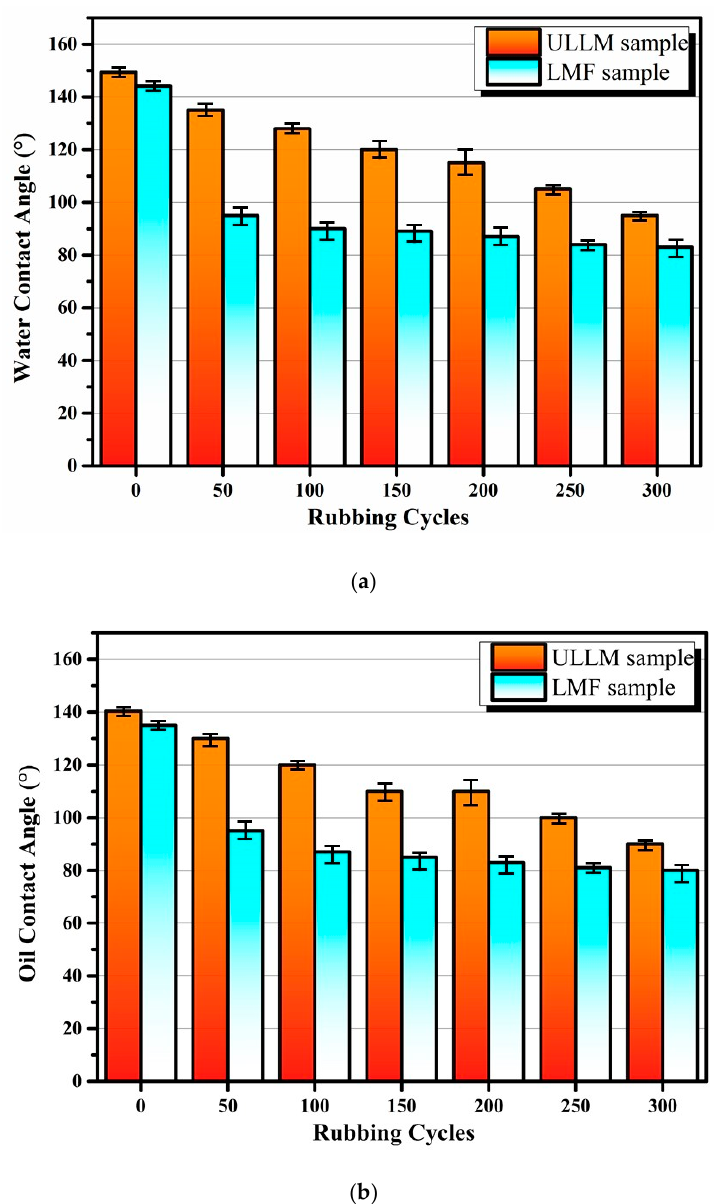
Figure 13. Variation of the water contact angles and oil contact angles with the number of rubbing cycles. ( a ) The water contact angles of ULLM and LMF sample decrease with the increase of rubbing cycles. ( b ) The oil contact angles of ULLM and LMF sample decrease with the increase of rubbing cycles.